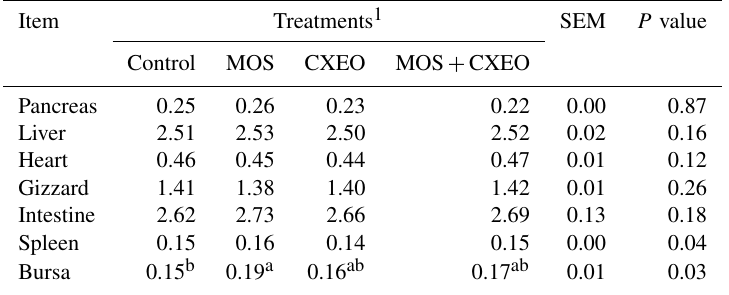
Table 3. Effect of mannan oligosaccharide (MOS) and Curcuma xanthorrhiza essential oil (CXEO) on relative organ weight in broilers subjected to heat challenge. SEM: standard error of the mean.